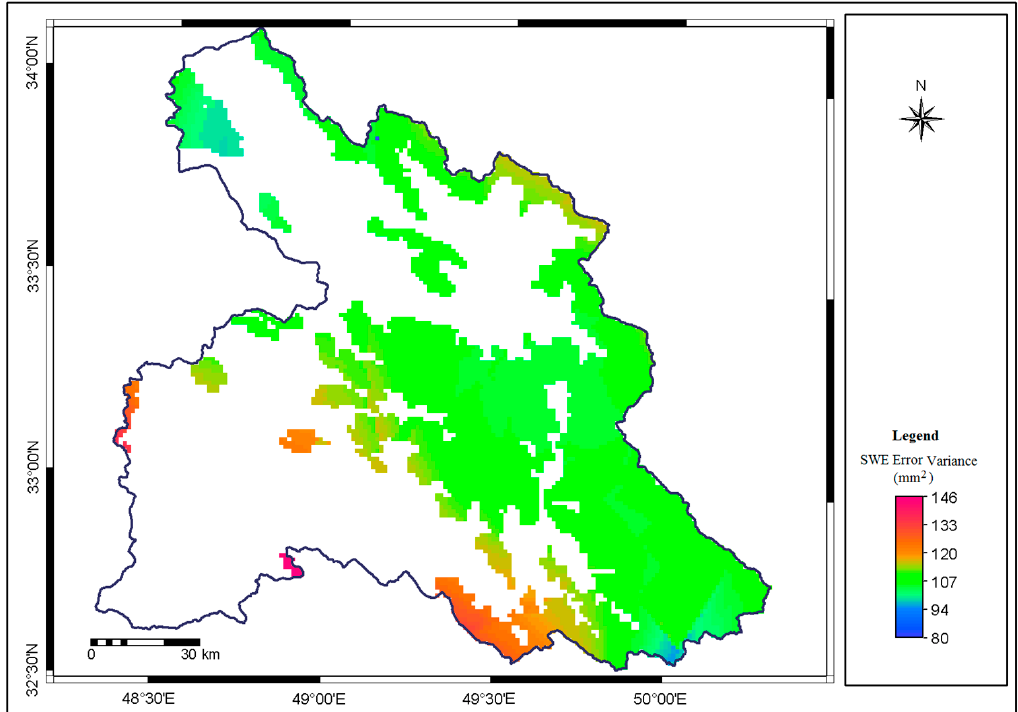
Figure 4. Error variance map of snow water equivalent for Dez Basin.